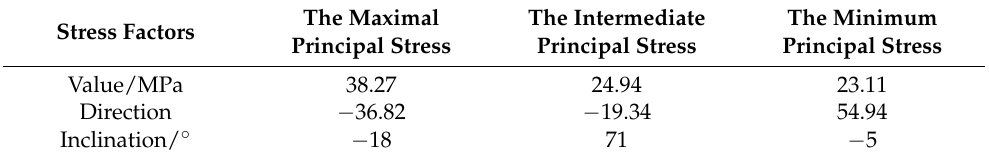
Table 1. Meaurement results of principal